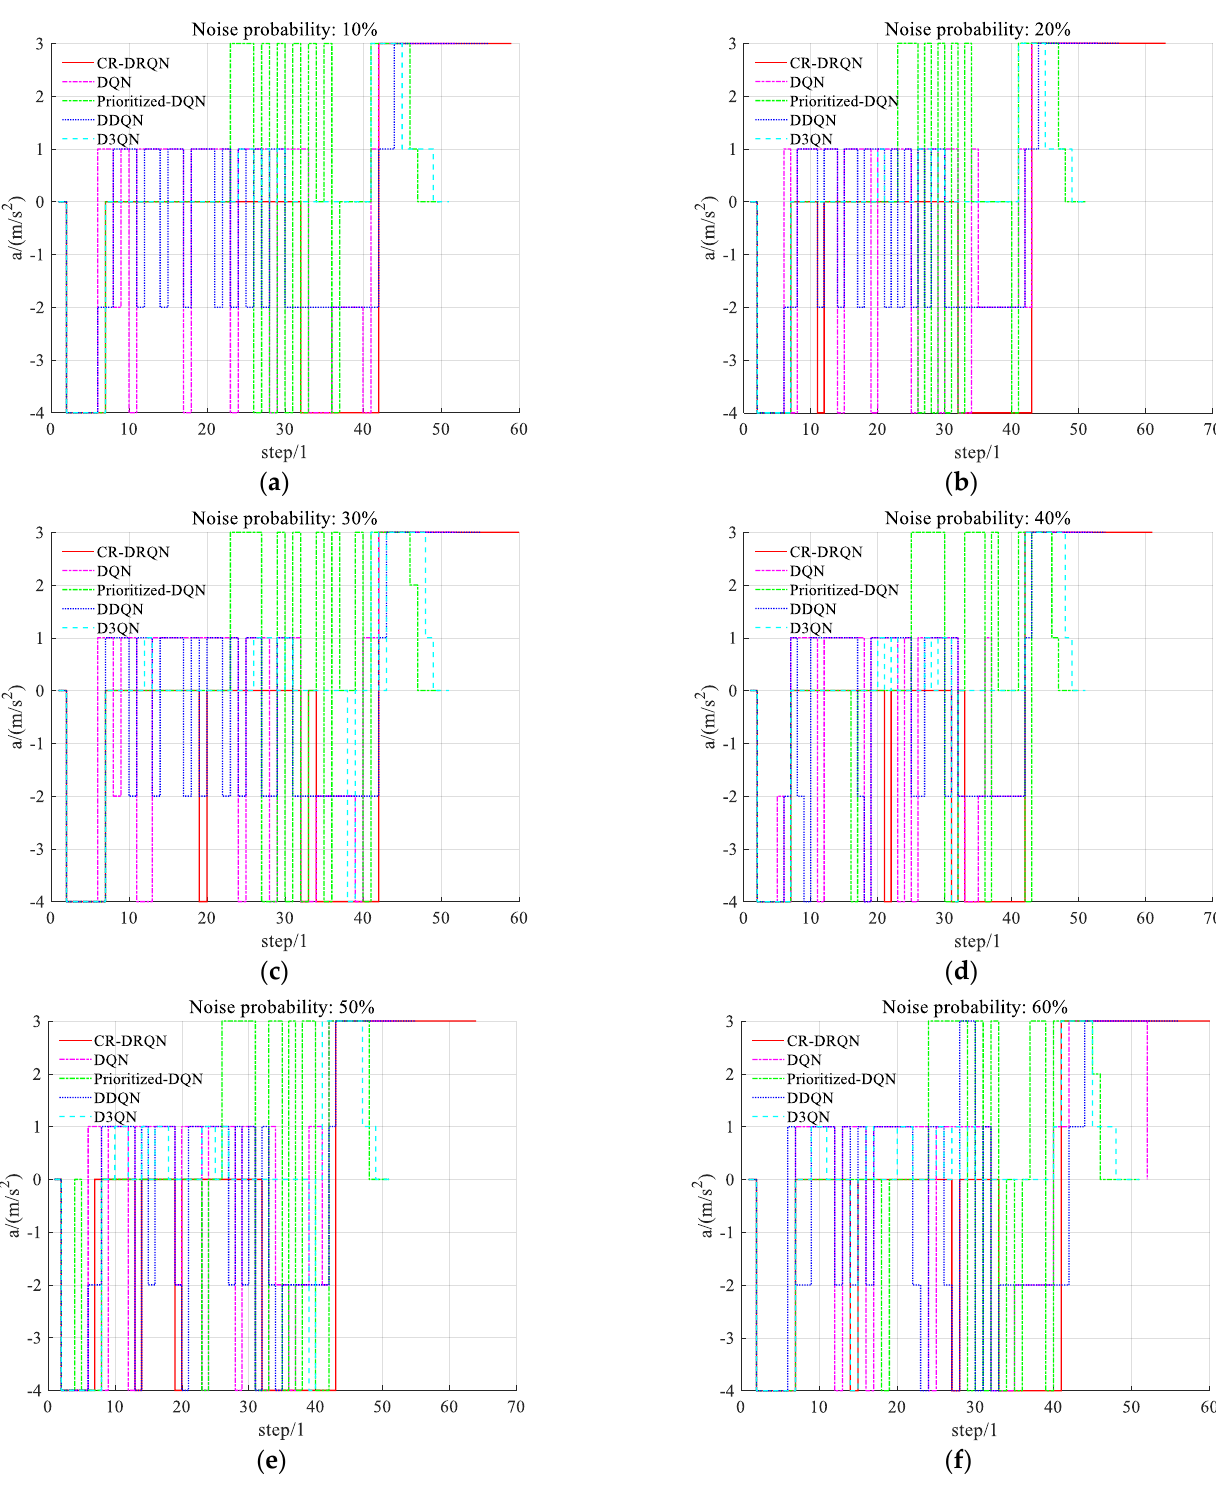
Figure 7. Action chose by CR-DRQN at different probabilities of noise occurrence. ( a – f ) present the results at the noise probabilities of 10–60% respectively.